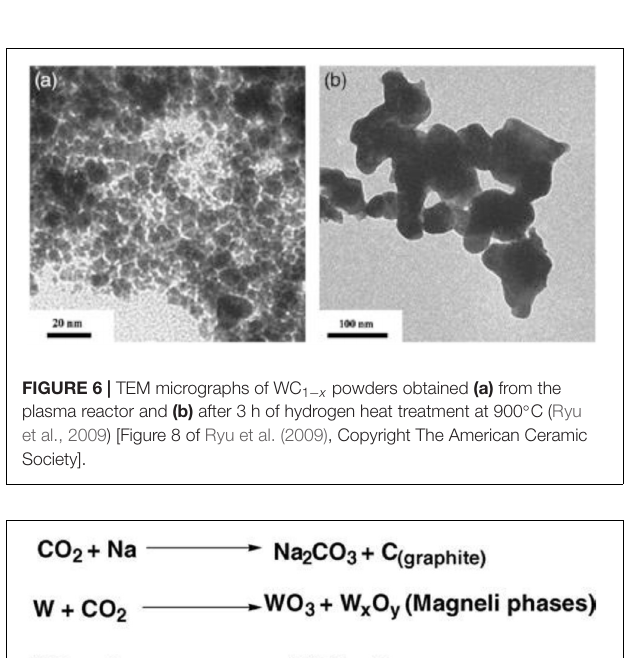
FIGURE 8 | (a) Low-resolution SEM image of the WC sample, (b) cross-sectional morphology of typical WC particles, (c) surface morphology of WC particles, and (d) SEM image of the residual graphite network (Wang et al., 2006) [Figure 2 of Wang et al. (2006), Copyright Elsevier B.V.]. Finally, the solid product was washed with distilled water and dried at 80 ◦ C for 2 h. The resultant WC powder is shown in Figure 8 ; Wang et al.